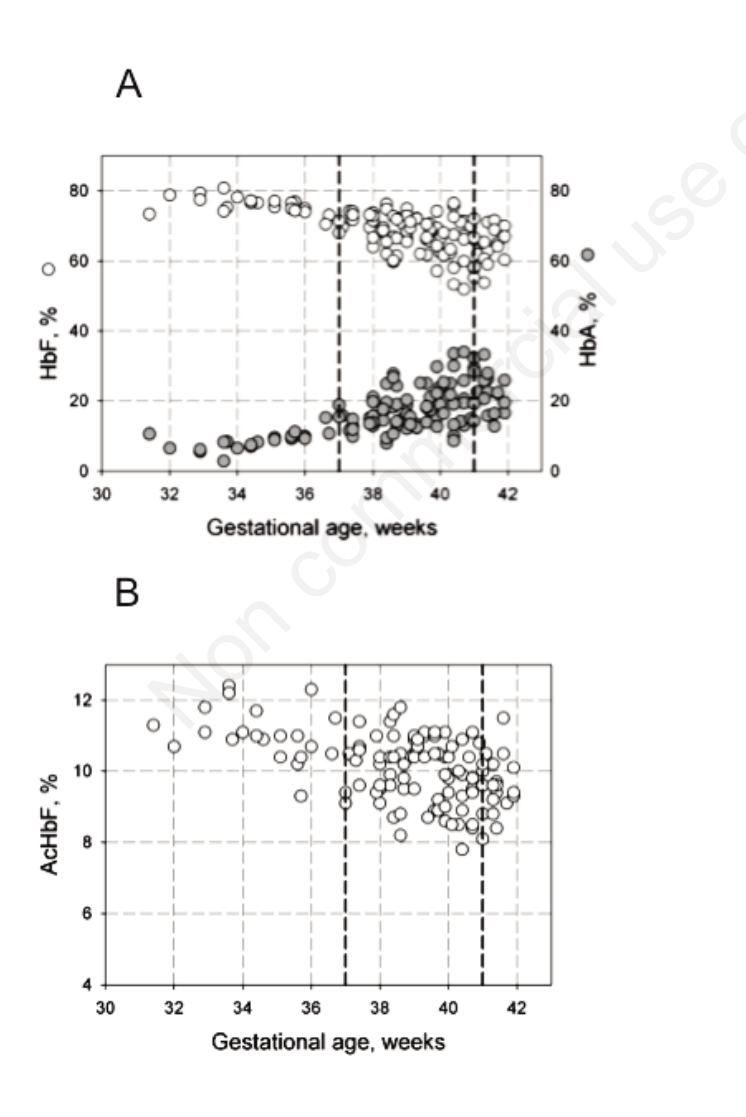
Figure 2. Fetal hemoglobin (HbF), HbA (A) and acetylated fetal hemoglobin (AcHbF) (B), in relation to gestational age (n=121). The dashed lines mark the physiologic deliv- ery period ( i.e . between the 37 th to the 41 st week of